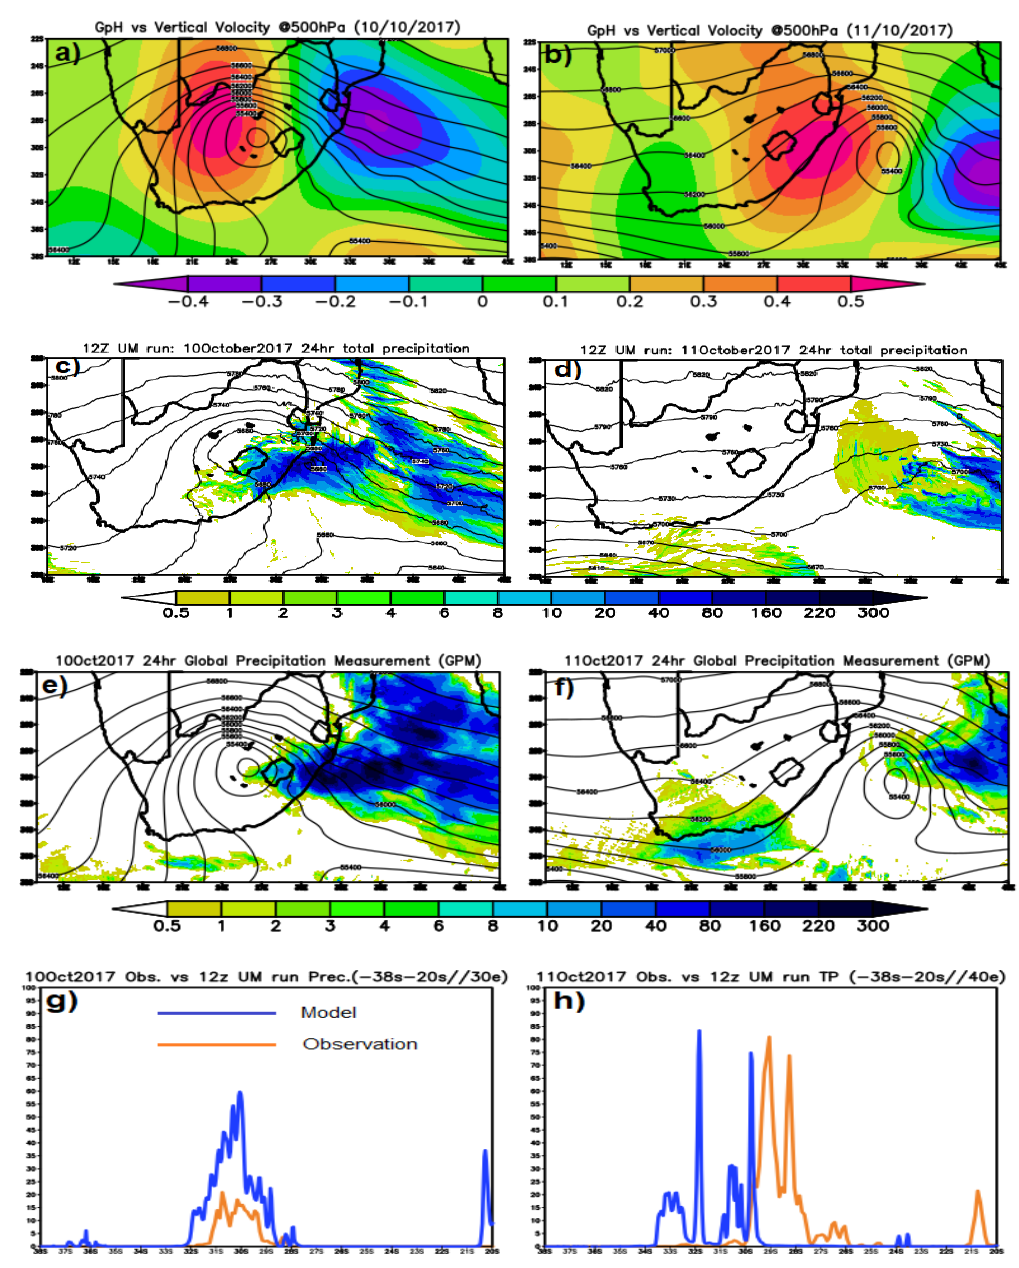
Figure 6. Geopotential height at 500 hPa (thin black contours) together vertical velocity (shaded) ( a , b ), at 12Z UM 24 h on the 10th and 11th October 2017. The second-row panels ( c , d ) show UM total precipitation (shaded) and geopotential height at 500 hPa, at the same as time as in the top panels. The third-row panels ( e , f ) show the total precipitation and geopotential height at 500 hPa for the ERA Interim for the same time as in ( a , b ). The bottom panels ( g , h ) show model (blue curve) and observation (orange curve) diurnal cycle precipitation for the same times as in ( a , b ).